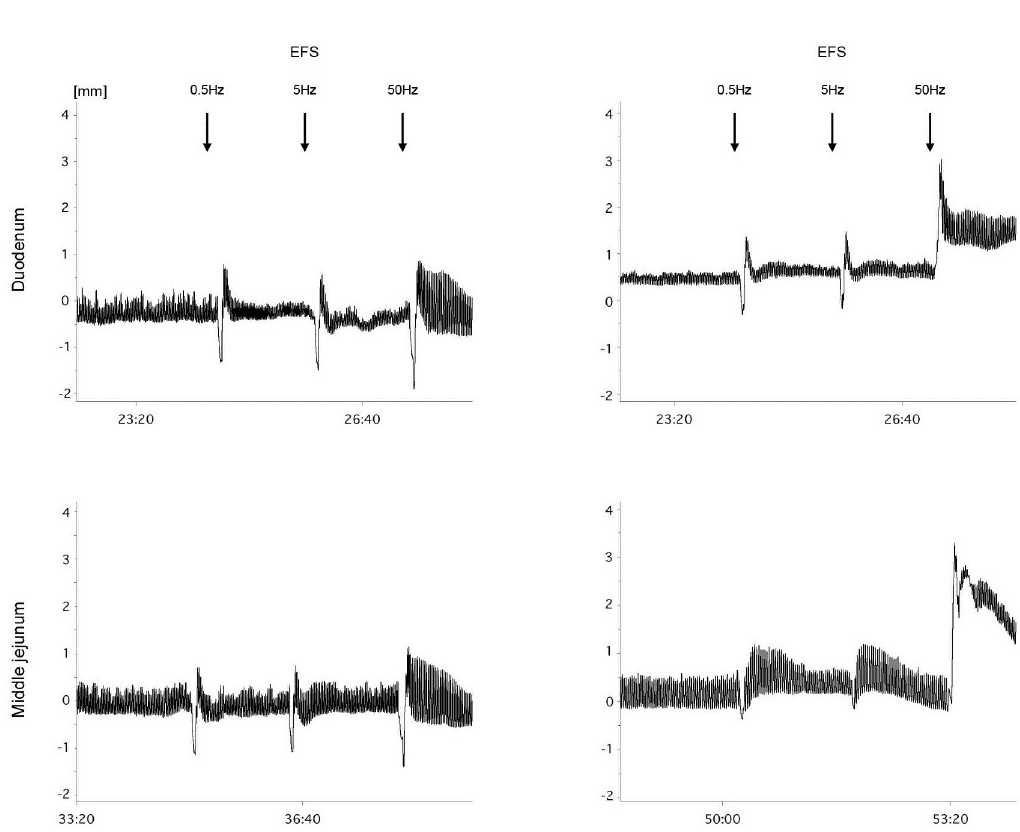
Fig 3. Representative trace of response to electrical field stimulation (EFS) [mm] in duodenum and middle jejunum of newborn piglets. EFS (0.5 Hz, 5 Hz, 50 Hz) in duodenal (upper panel) and middle jejunum (lower panel) segments from piglets fed milk formula with intra-stomach administrations of 0.9% NaCl–C, every 8 hours (left graphs) and obestatin (15 μ g/kg BW– O15) (right